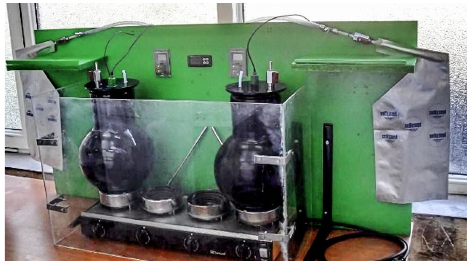
Figure 2. Front image of the test rig for 5 L